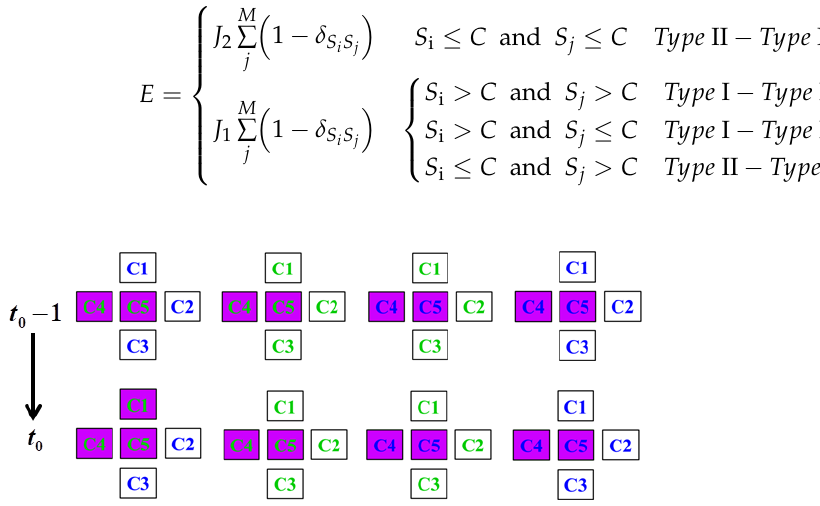
Figure 3. The movement of different types of grain boundaries according to the second step of the CA model.